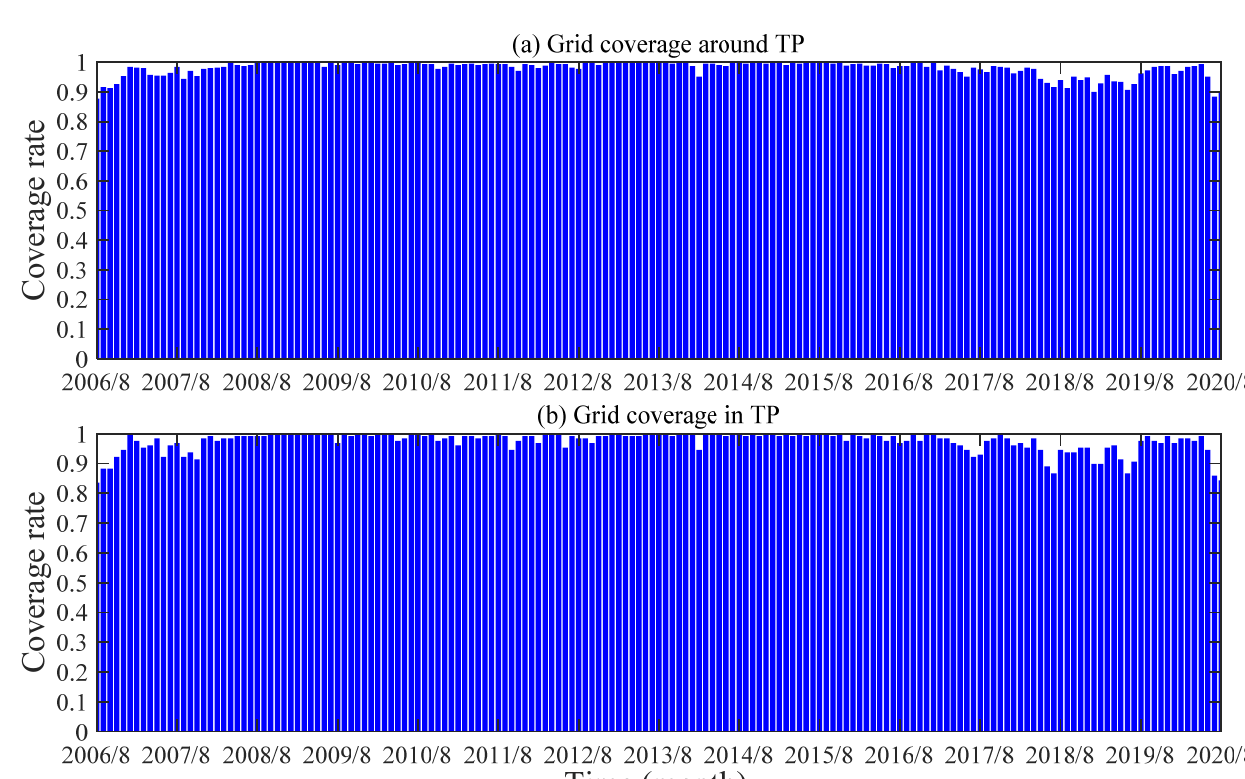
Figure 4. The monthly grid (2° × 2°) coverage of GNSS RO events ( a ) around TP (20~50°N, 60~120°E) and ( b ) in (25~41°N, 68~105°E) the TP from August 2006 to September 2020.